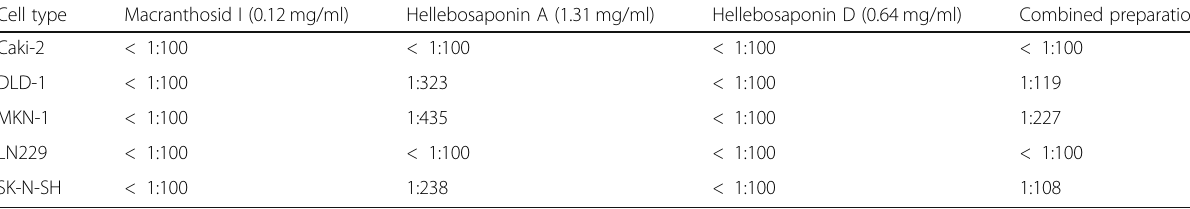
Table 3 IC 50 DF of the characteristic compounds at concentrations levels present in HNE Cell type Macranthosid I (0.12 mg/ml) Hellebosaponin A (1.31 mg/ml) Hellebosaponin D (0.64 mg/ml) Combined